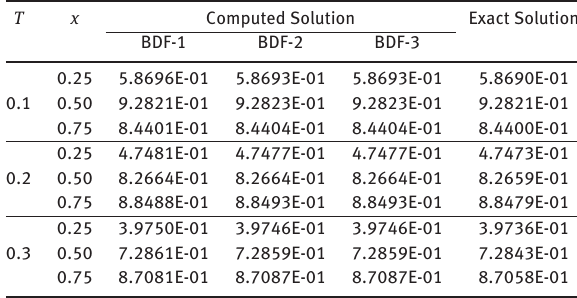
Table 7: Numerical solutions obtained by proposed schemes and the exact solutions for Example 2: ν = 0.05 , Δx = 0.0125 and Δt = 0.0001 .